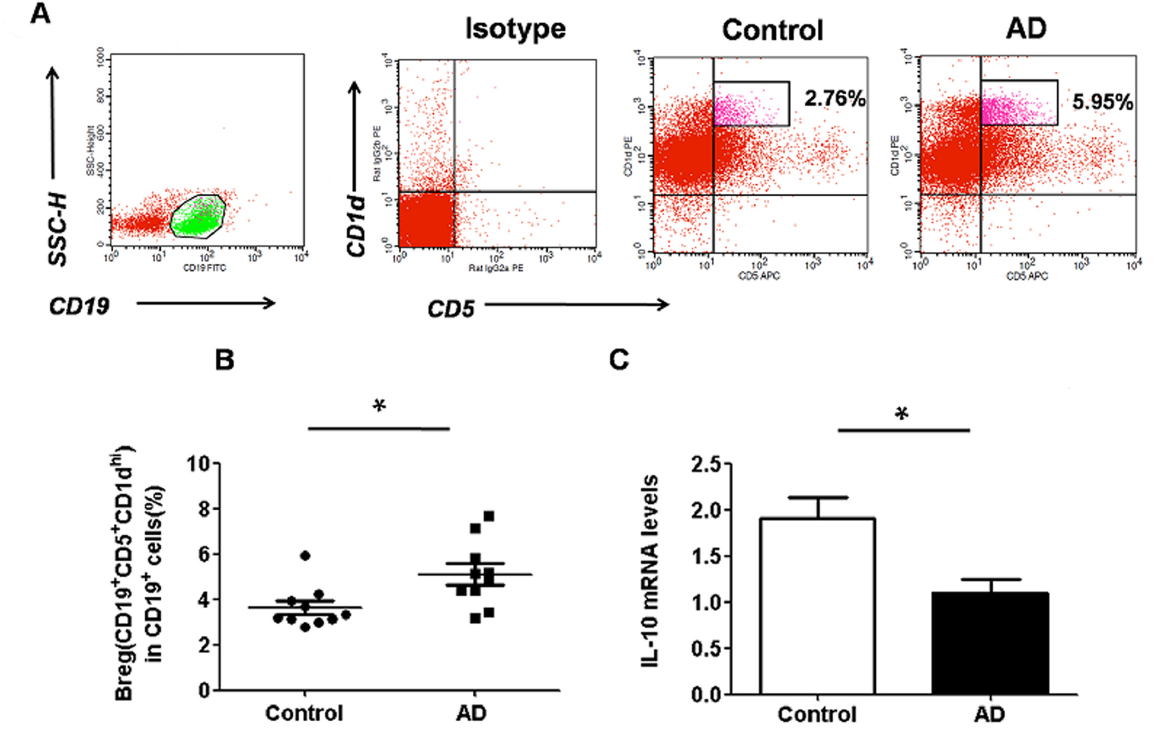
Fig 1. Regulatory B10 cells are augmented and the level of IL-10 expression is decreased in the spleen of AD mice. (A) Representative dot-plots showing the percentage of CD5 + CD19 + CD1d hi B10 cells in control (n = 10) and AD mice (n = 10); (B) Bar graph depicting the percentage of CD5 + CD19 + CD1d hi B10 cells in control and AD mice as analyzed by flow cytometry. The percentage of CD5 + CD19 + CD1d hi B10 cells was significantly higher in the AD group than that observed in the control. Data are expressed as mean ± SEM. * P < 0.05, asanalyzed by one-way ANOVA, followed by Tukey multiple-comparison test; (B) The level ofIL-10 mRNA expression decreased in the spleen of AD mice (n = 10) compared to that of control (n = 10). Data are expressed as mean ± SEM. * P < 0.05, as analyzed by one-way ANOVA, followed by Tukey multiple-comparison test.